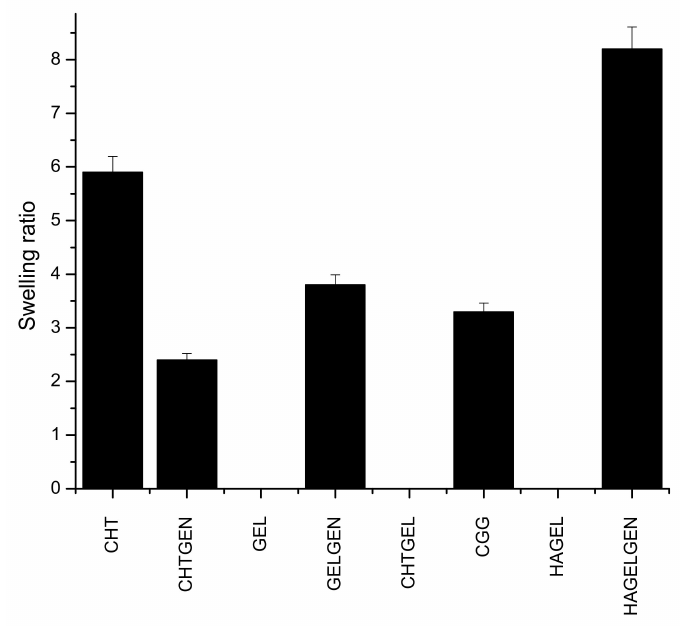
Figure 9. Bar graph showing the swelling ratio of each formulation (n =